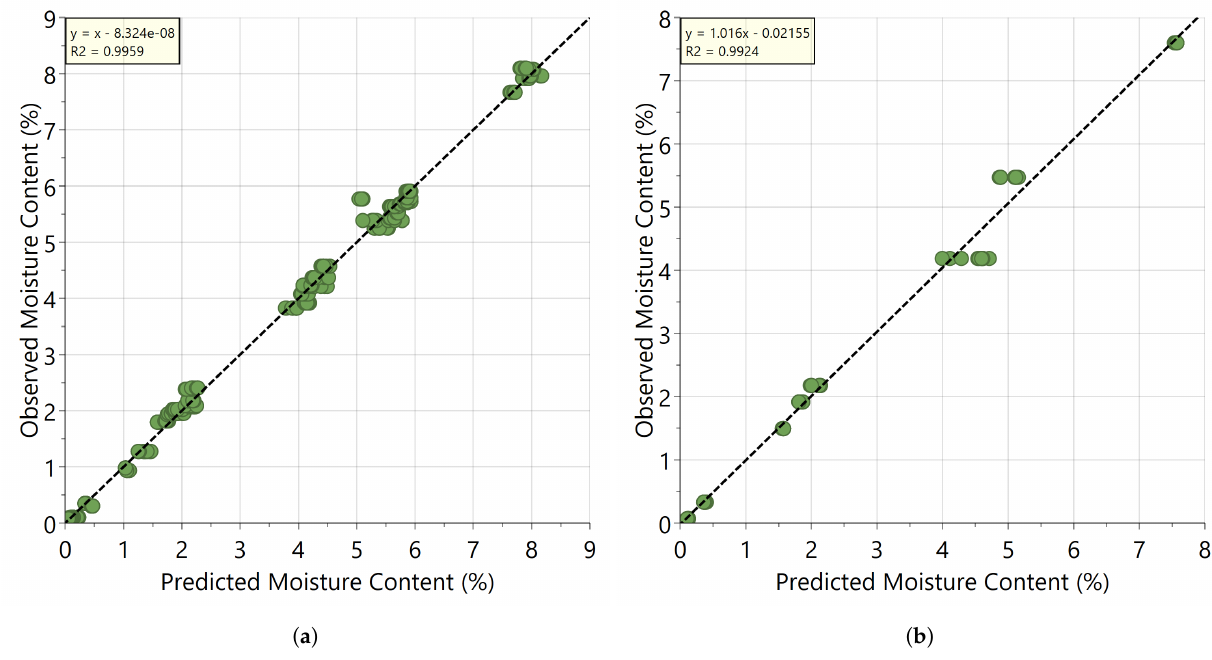
Figure 3. Observed residual moisture content versus predicted plot using SNV-SG corrected data in the range of 1865–2200 nm: ( a ) calibration set; ( b ) validation